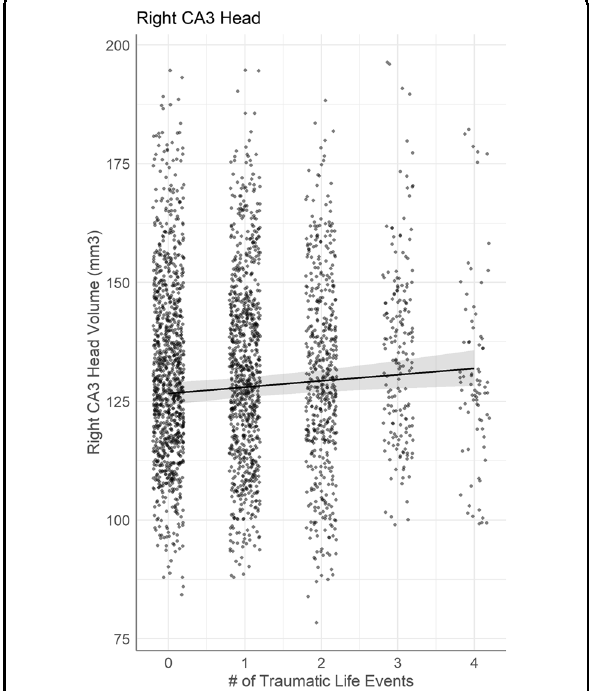
Fig. 2 Hippocampal sub fi eld volume predicted by the conditional main effect of lifetime trauma (measured at baseline). Individual data points represent volume measured at subject scan